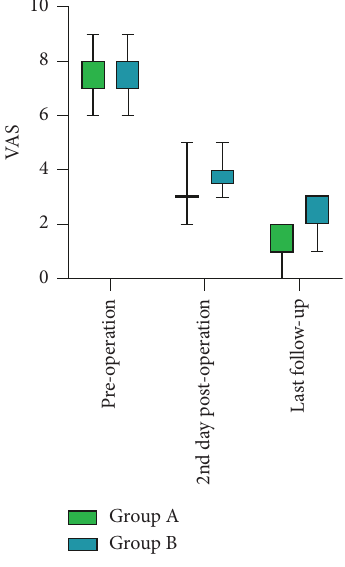
Figure 3: VAS between the groups. Figure 4: ODI between the